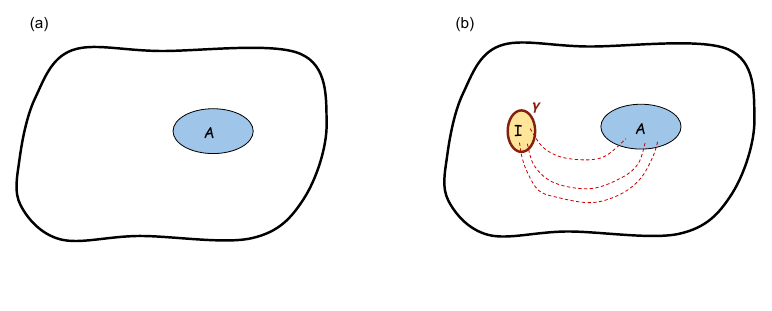
Figure 1. Illustration of the QES formula in eq. (1.1) for two di(cid:11)erent situations. The curved black lines represent a Cauchy surface. (a) (cid:6) = A when the formula reduced to the ordinary quantum (cid:12)eld theory entropy. (b) (cid:6) = A [ I when a new quantum extremal surface (cid:13) = @I appears, contributing an area law entropy j (cid:13) j . The quantum (cid:12)eld theory entropy becomes S qft 4 G N can reduce the entropy when there is entanglement between I and A , as is indicated by the red dashed